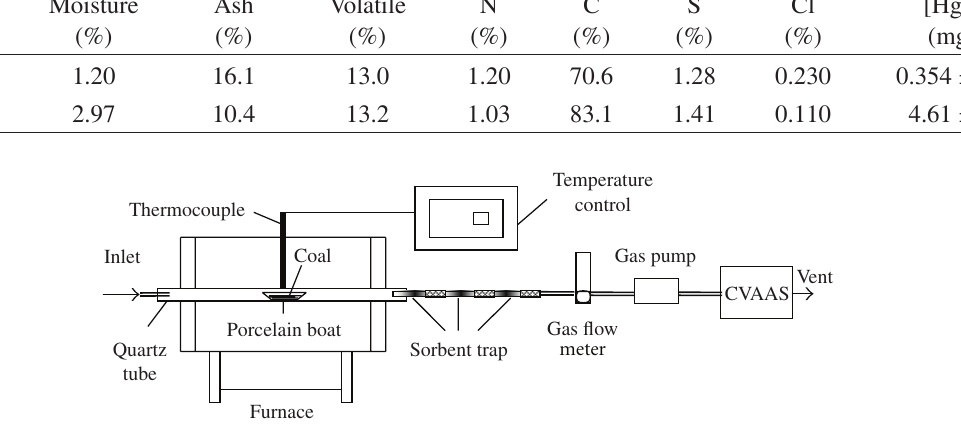
FIGURE 1: Schematic diagram of the coal combustion and sampling